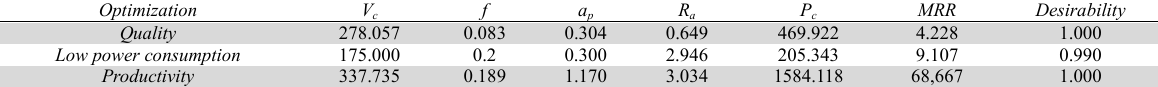
Summary of values obtained for the three individual cases of optimization Optimization